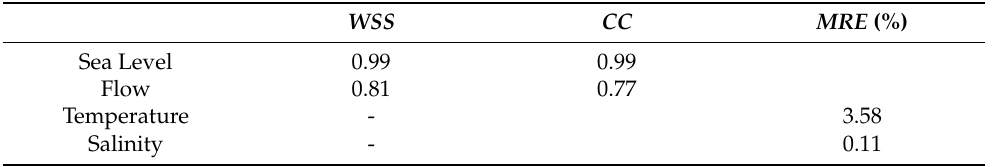
Table 2. Validation results of sea level and